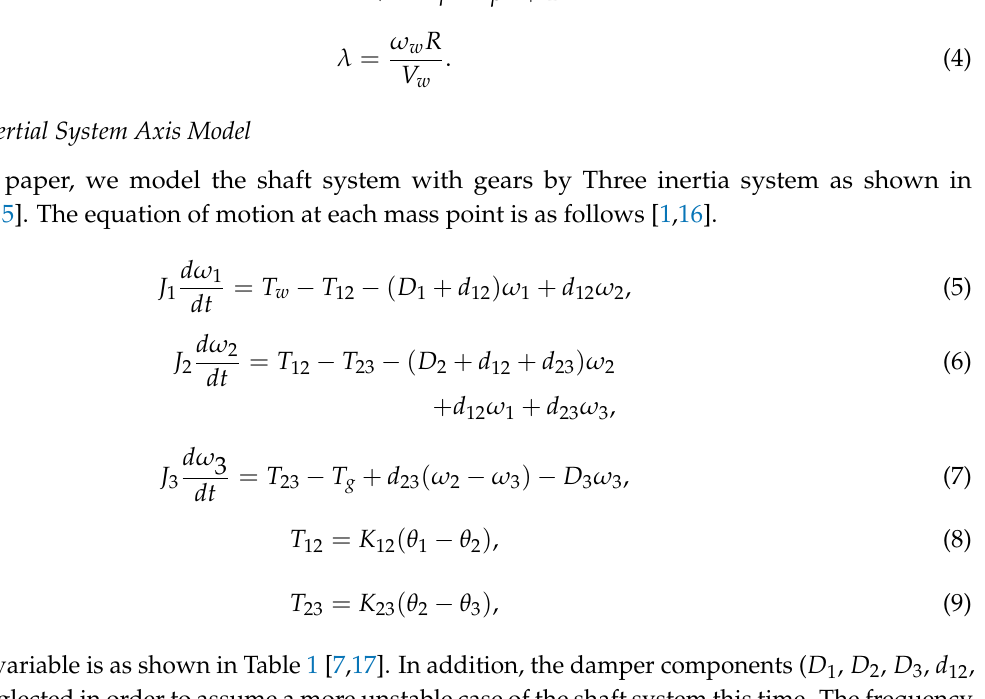
Figure 2. Three mass model.